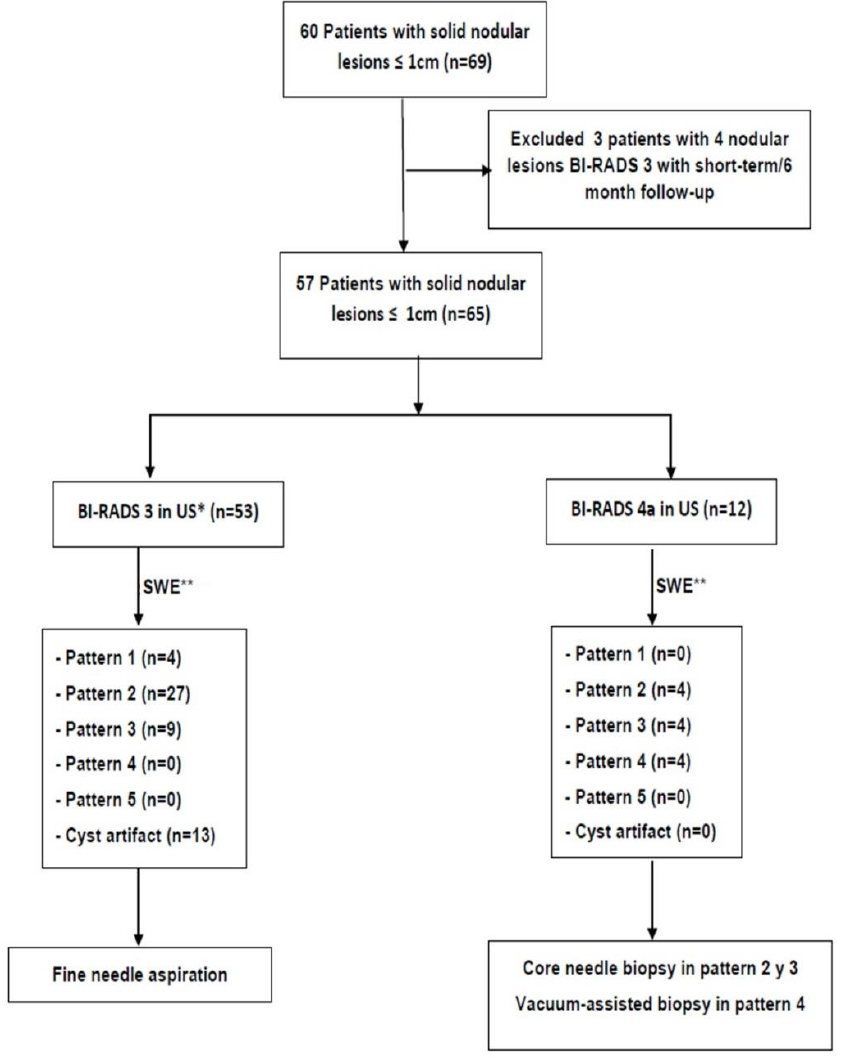
Figure 2. Management algorithm. * Ultrasound. ** Shear wave elastography. BI-RADS—Breast Imaging Reporting and Data System (BI-RADS).